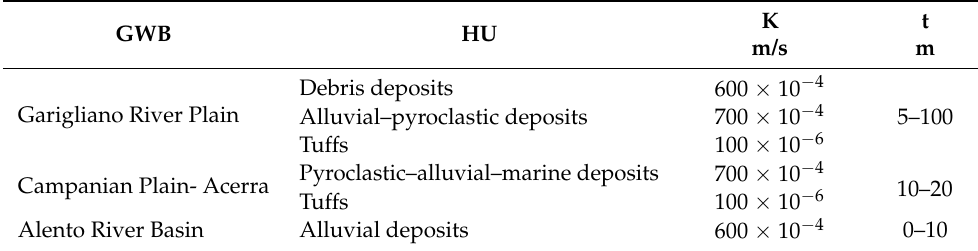
Table 2. Hydraulic conductivity (K) and thickness (t) of the hydrogeologic units (HU) of the vadose zone for each groundwater body (GWB).